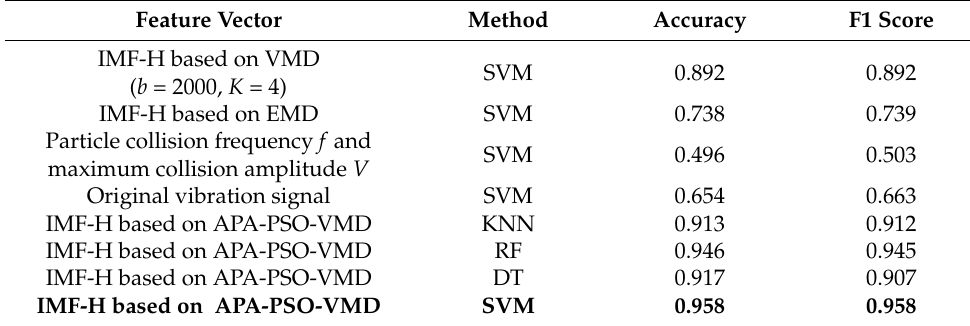
Table 5. The results of different diagnosis models for metal particle